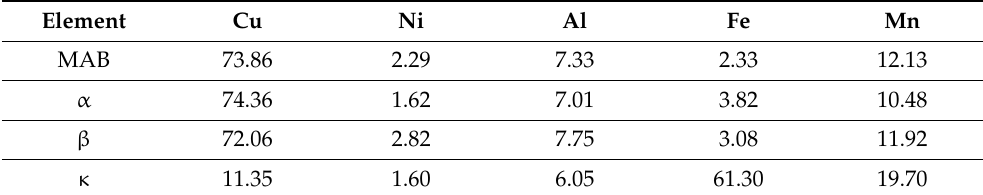
Table 4. Batch analysis data of MAB alloy (as-received) and the composition of the phases from EDS analysis (wt.%) in the AR state.